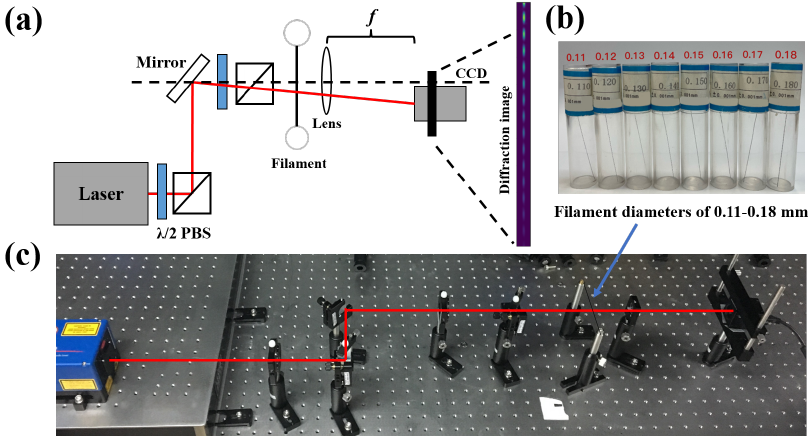
Figure 1. Experimental setup for diffraction measurements: ( a ) the diagram of the experimental setup; polarization beam splitters (PBS) are used to adjust the laser intensity, f is the focal length of the lens, the wavelength of laser is 780.24 nm, and λ /2 is the half-wave plate, the pixel size of CCD (MV-CA050-20UM) is 4.8 µ m, and the resolution of CCD is 2592 × 2048; ( b ) some of the actual filaments; ( c ) actual photograph of the diffraction